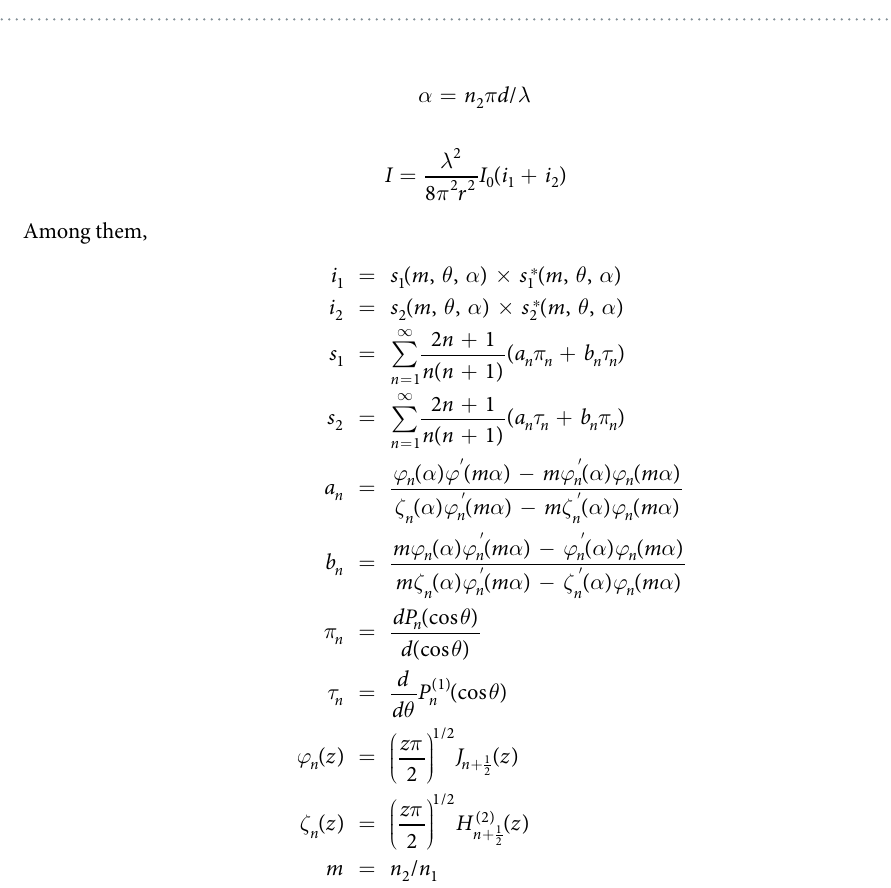
Figure 3. ( a ) DSC curves of pure polymers and their blends with OSB. ( b ) SEM micrographs of 2-0-1.0